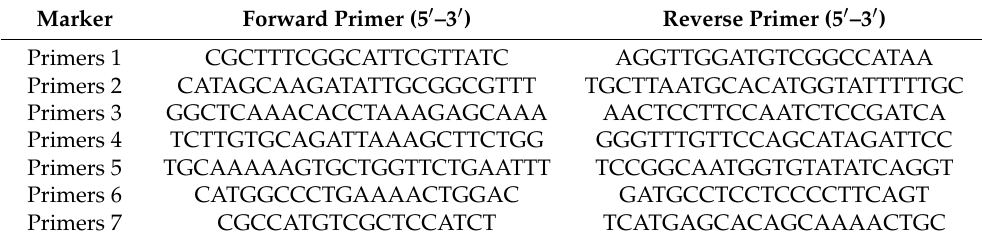
Table 3. Seven pairs of primer information for DNA sequencing.